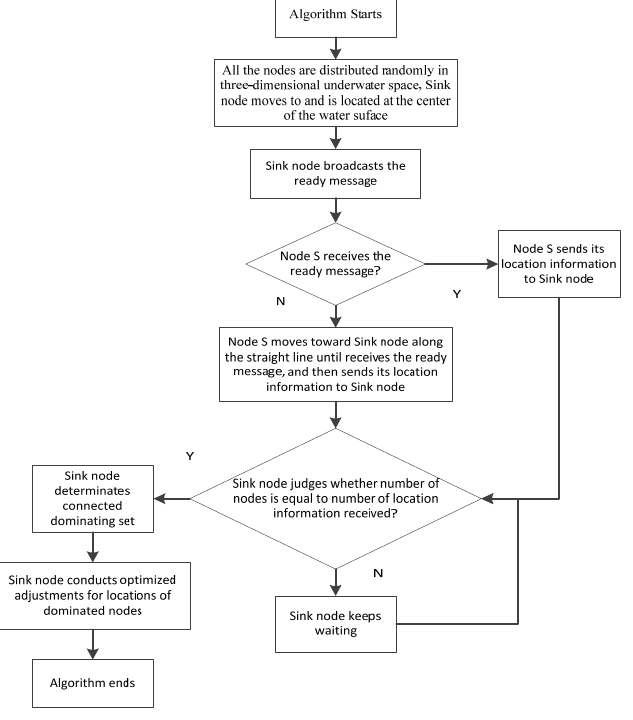
Figure 4. Process of DBCDS algorithm.